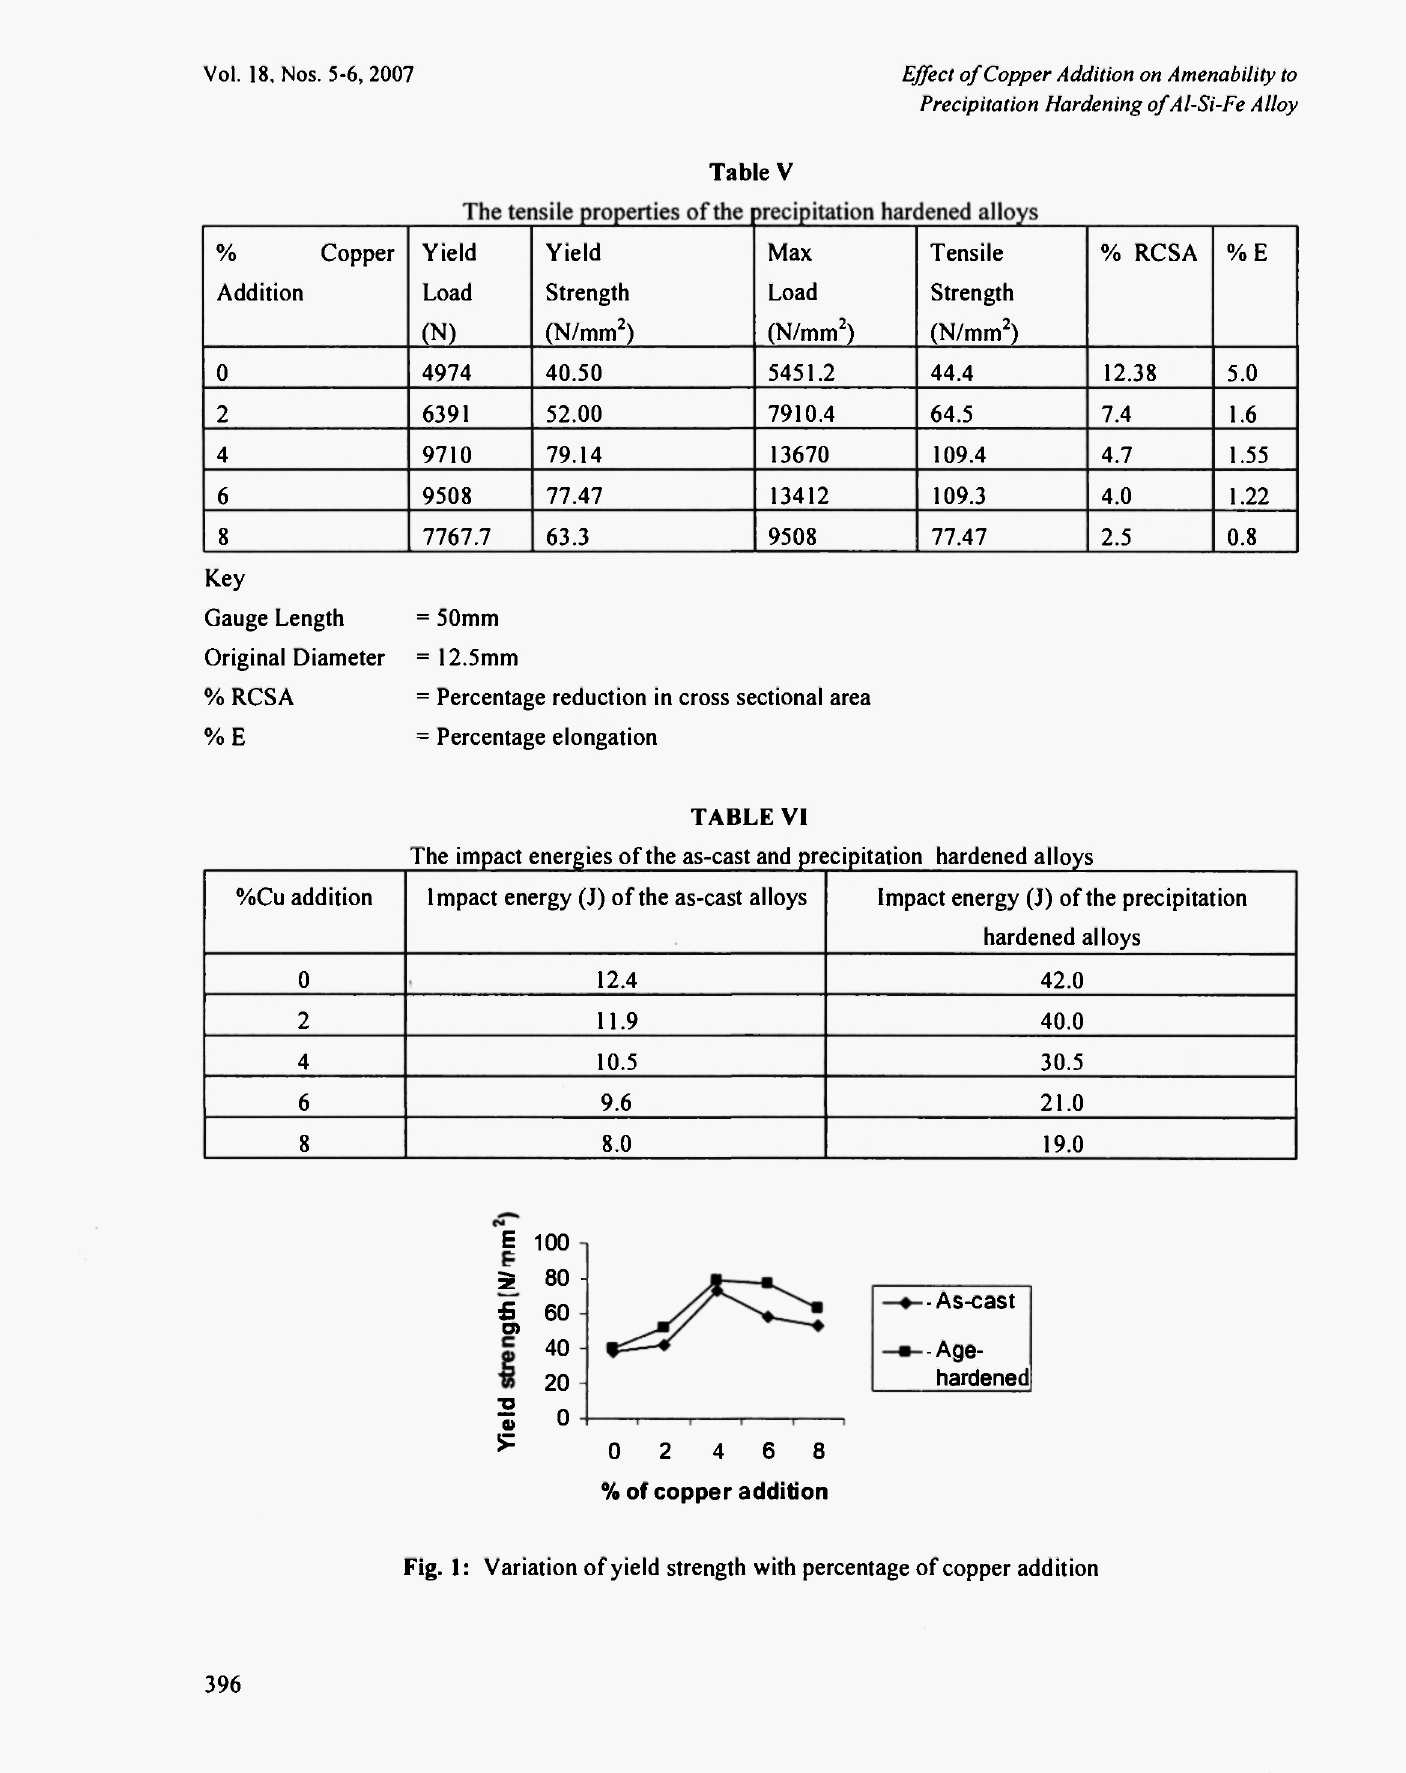
Fig. 1: Variation of yield strength with percentage of copper